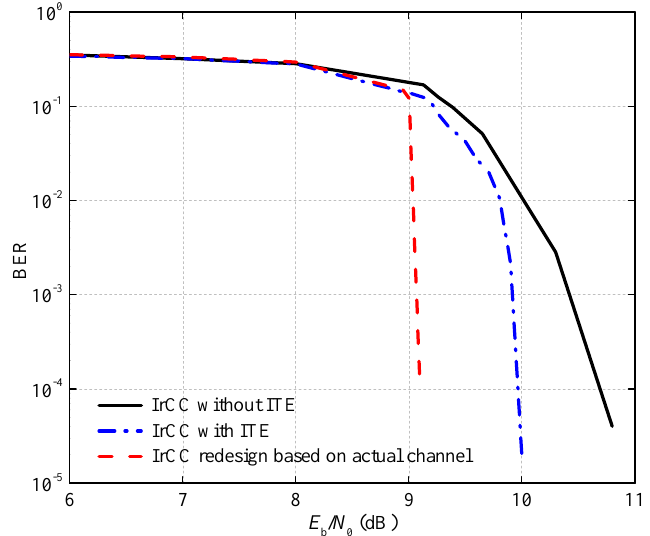
Figure 12. Performance comparison of three encoding and decoding schemes in the actual channel, k =